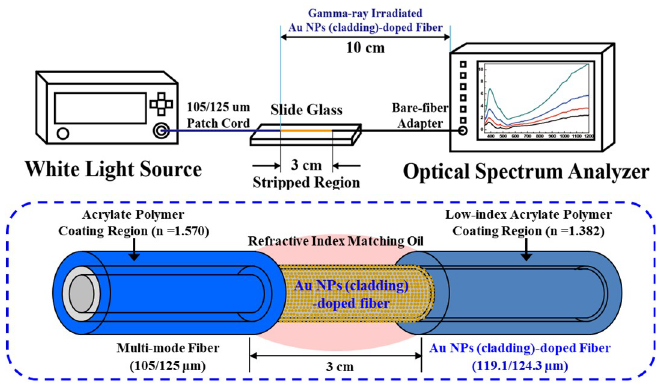
Figure 1. Schematic diagram of the SPR measurement set‐up using the optical fiber incorporated with Au NPs in the cladding. Au NPs in the